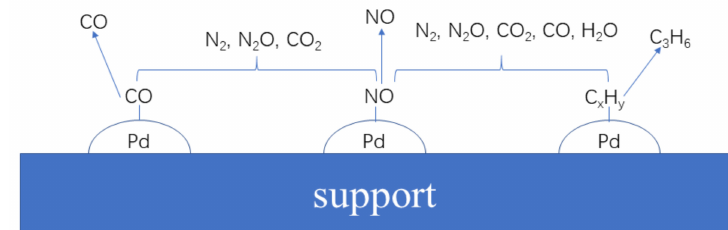
Figure 8. Scheme of the reaction paths in desorption stages for